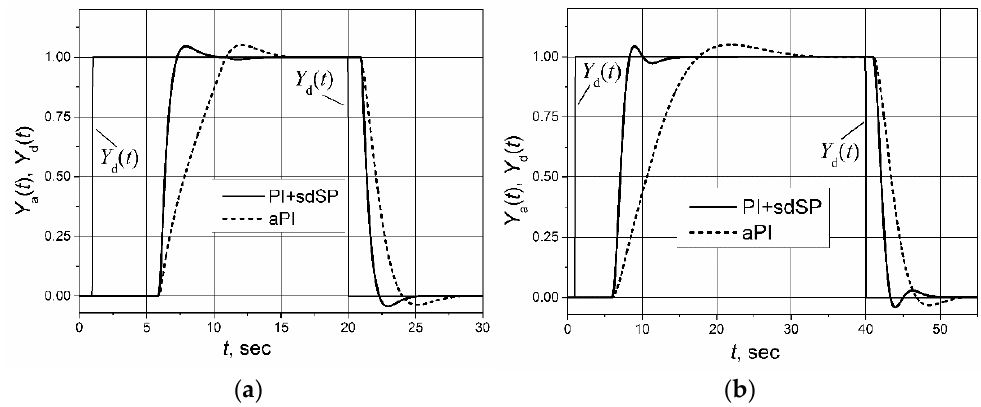
Figure 8. The set-point unit pulse response of the control system of the first-order ( a ) and second- order plants ( b ) with asymmetric response delay ( T r = 5 s, T f = 1 s) based on the asymmetric PI (aPI) controller and the PI controller with the switched-delay Smith predictor (sdSP).